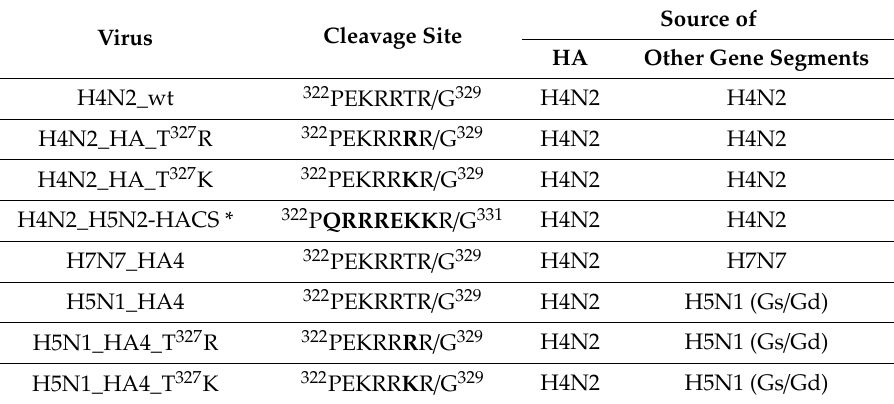
Table 1. Recombinant viruses generated in this